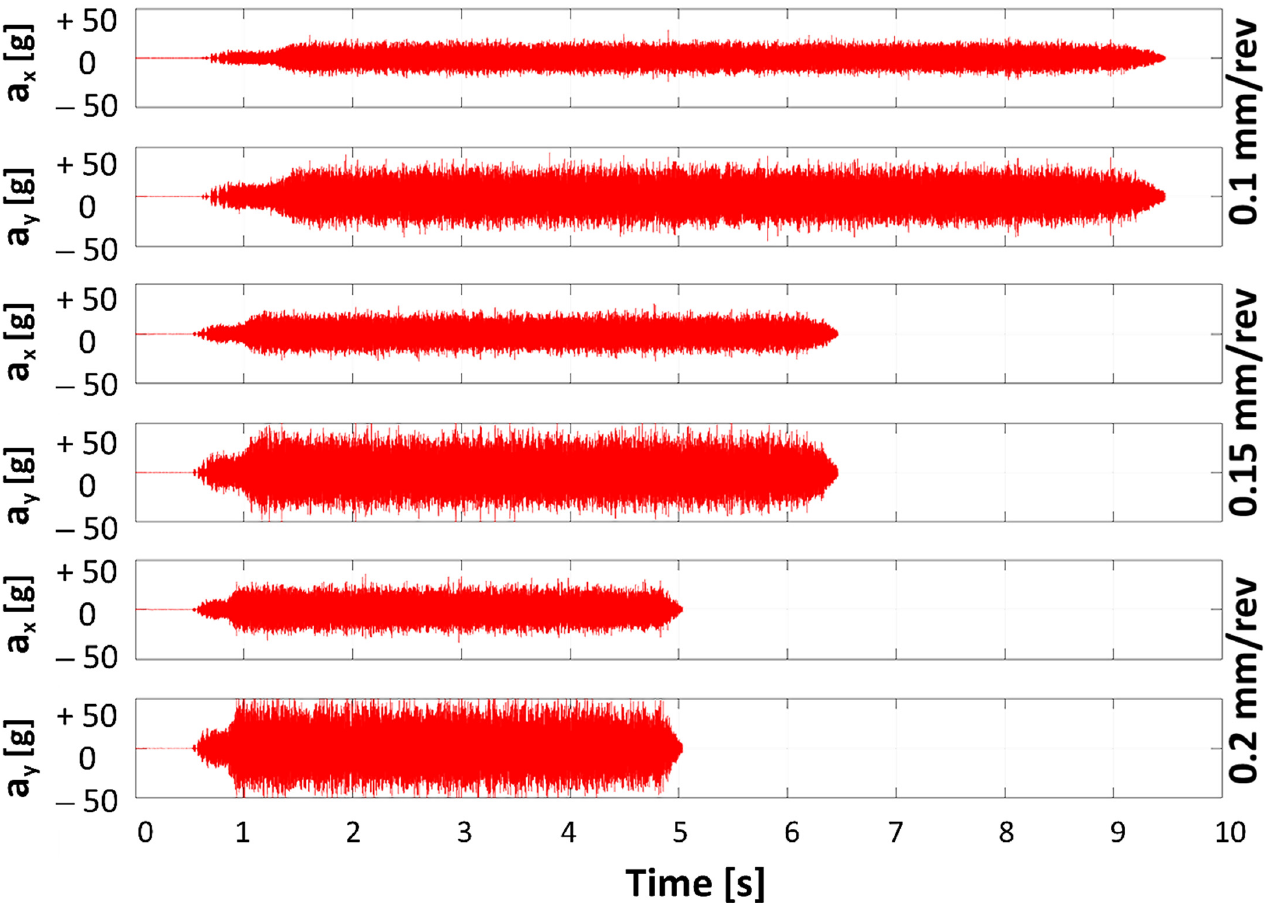
Figure 5. FFT plots of the acceleration signal in x and y coordinates with respect to time for the top side of the ZnO ceramic under different feed velocities.